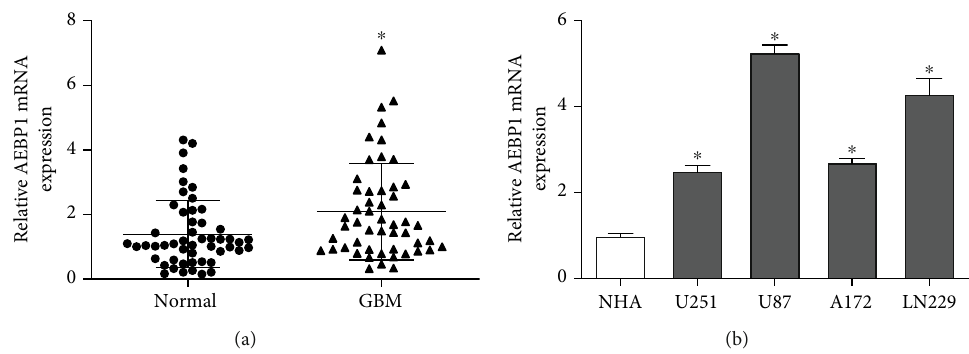
Figure 2: Expression of AEBP1 in (a) GBM tissues and (b) cell lines. ∗ P < 0 : 05 . 1: Relationship between AEBP1 expression and clinicopathological features in GBM